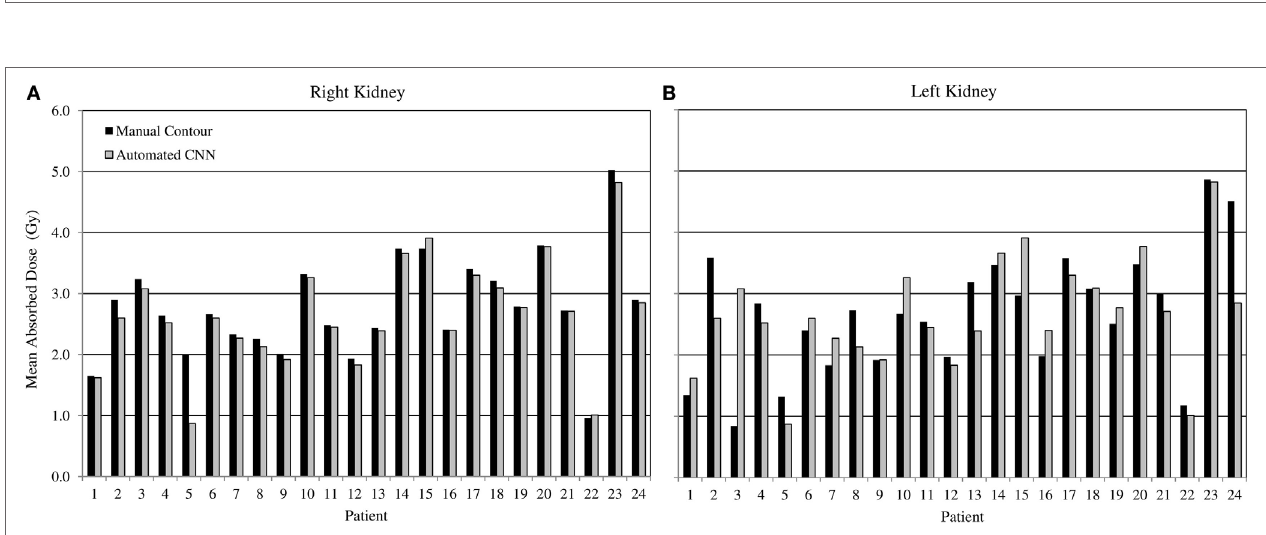
FigUre 6 | Estimated radiation absorbed dose applying either manual (black) or automated convolutional neural network segmentation (grey) to determine mean radiation absorbed to right and left kidneys from 3D voxel dose maps. Results for right (a) and left (B) kidneys are presented independently.